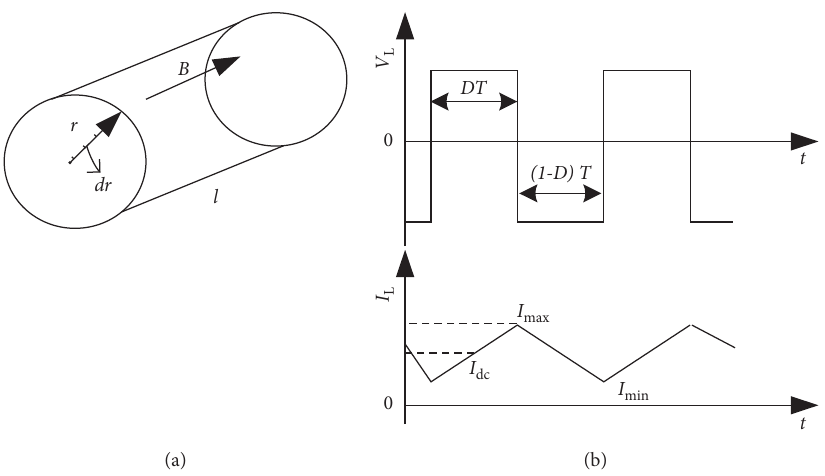
Figure 11: Core analogy diagram and excitation inductance voltage and current